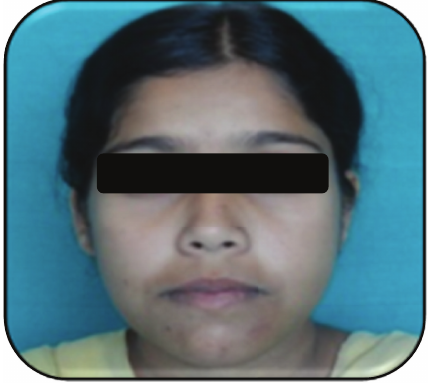
Figure 1: Preoperative extraoral photograph.